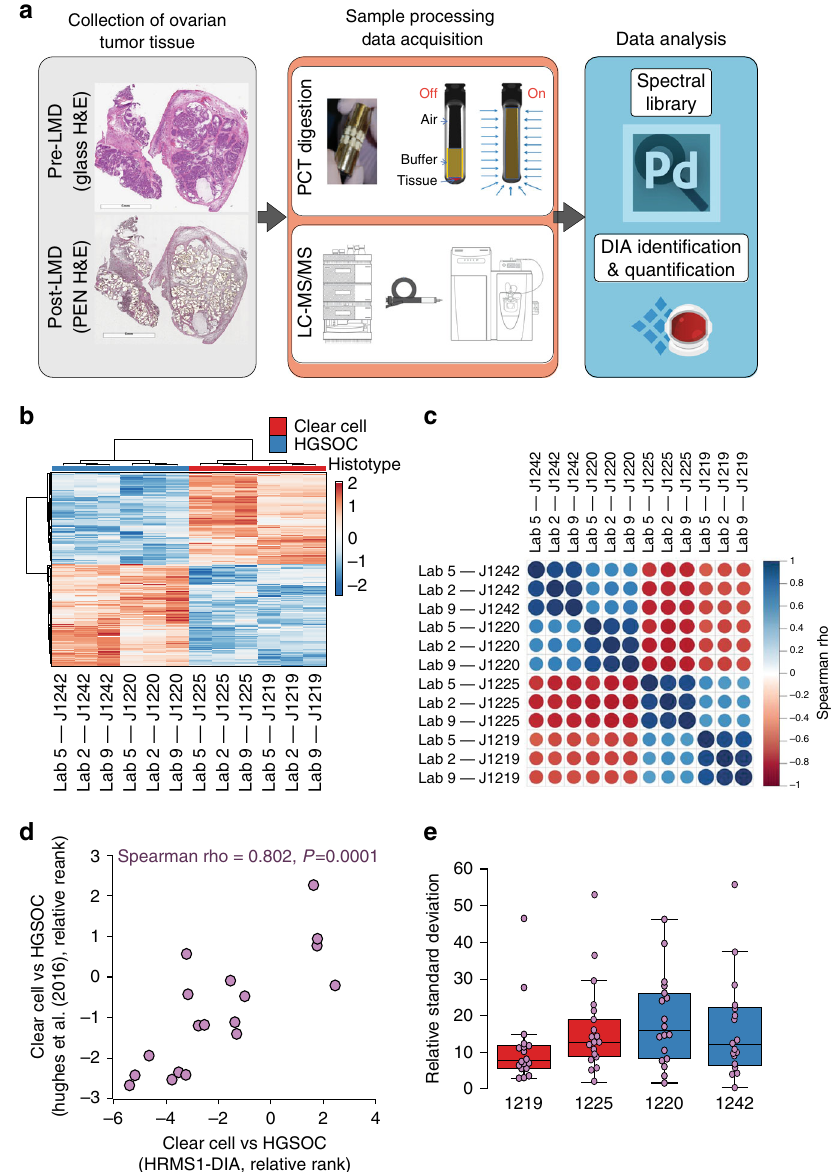
Fig. 6 Archival ovarian cancer tissue sample analysis using HRMS1-DIA at three analytical sites. a Epithelial cancer cells were laser microdissected from formalin- fi xed, paraf fi n-embedded (FFPE) archival ovarian clear cell carcinoma (OCCC, n = 2) and high-grade serous ovarian carcinoma (HGSOC, n = 2) tumor, digested by pressure-cycle technology, and evaluated by three international labs using the standardized HRMS1-DIA analytical work fl ow. Each biological sample was analyzed by HRMS1-DIA as three technical replicates. Quality control standards were evaluated before, between, and after the archival cancer tissue samples. The data acquisition was performed in a 24/7 operation mode. b Unsupervised cluster analysis of 394 proteins that were signi fi cantly altered (LIMMA adjusted p value < 0.01) between OCCC (red) and HGSOC (blue) tissues. c Correlation plot of proteins signi fi cantly altered across analytical sites and disease histotypes. d Correlation of proteins identi fi ed as altered in OCCC and HGSOC tissues in this study with a gene signature identi fi ed by Hughes et al. 32 . We co-quanti fi ed 18 signi fi cant protein alterations (LIMMA p value < 0.05) with this historic 112 gene signature stratifying OCCC and HGSOC ovarian cancers. Protein alterations were signi fi cantly correlated with this feature subset (Spearman = 0.802, p = 0.0001). e Quantitative reproducibility of 18 OCCC and HGSOC signature proteins across three analytical sites by patient tissue sample ( n = 2 unique OCCC and n = 2 unique HGSOC patients). The fi gure shows the relative standard deviation between protein abundances obtained for the 18 signature proteins quanti fi ed at the three analytical sites. Boxplots re fl ect median RSD at midpoints as well as upper and lower limits of interquartile RSD